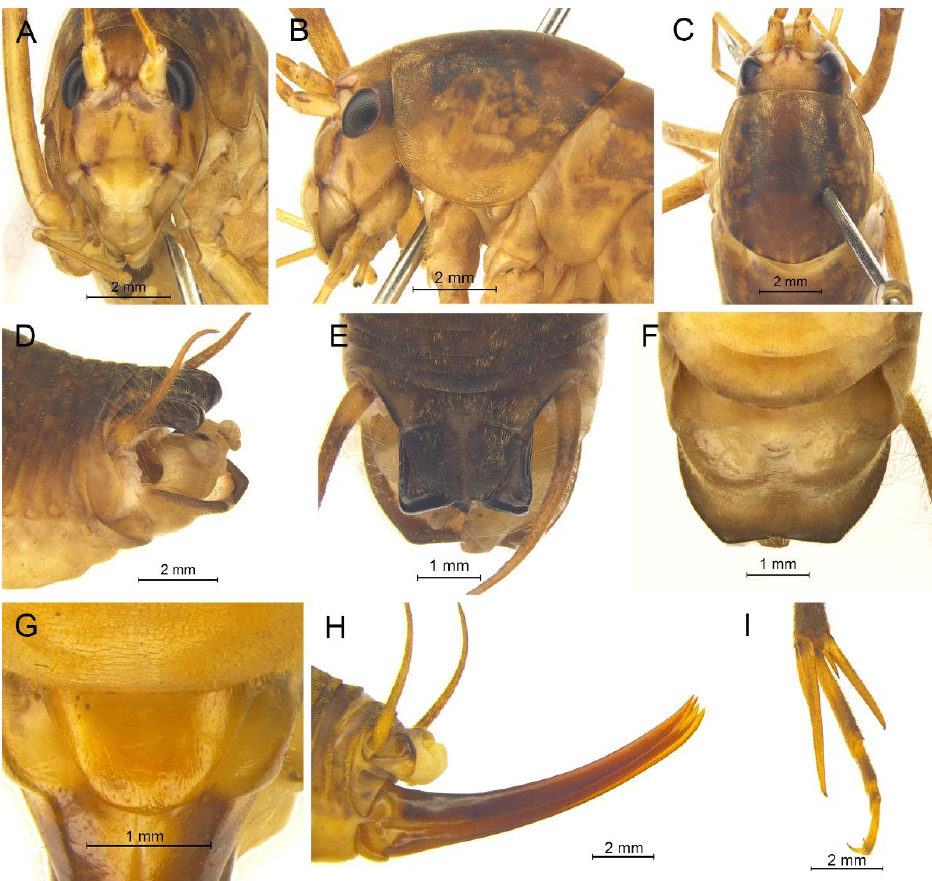
Figure 10. Pseudotachycines procerus Zhu & Shi sp. nov., male: ( A – C ) head and pronotum: ( A ) frontal view, ( B ) lateral view, ( C ) dorsal view; ( D – F ) apex of abdomen: ( D ) lateral view, ( E ) dorsal view, ( F ) ventral view; ( I ) hind tarsus in lateral view; female: ( G ) subgenital plate in ventral view; ( H ) ovipos- itor in lateral view.